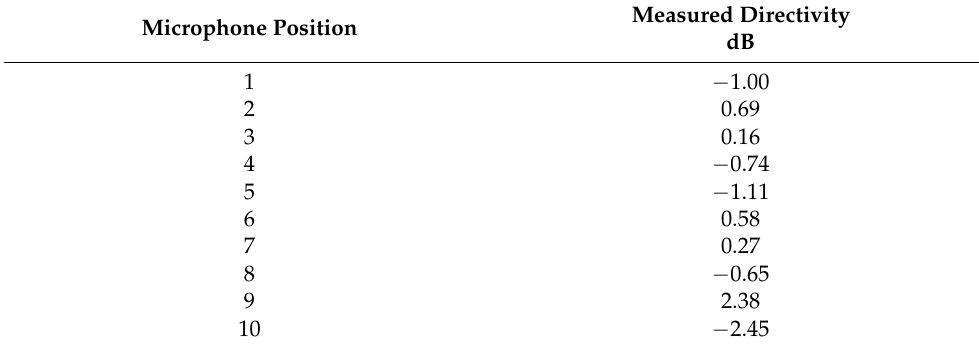
Table 3. Measured